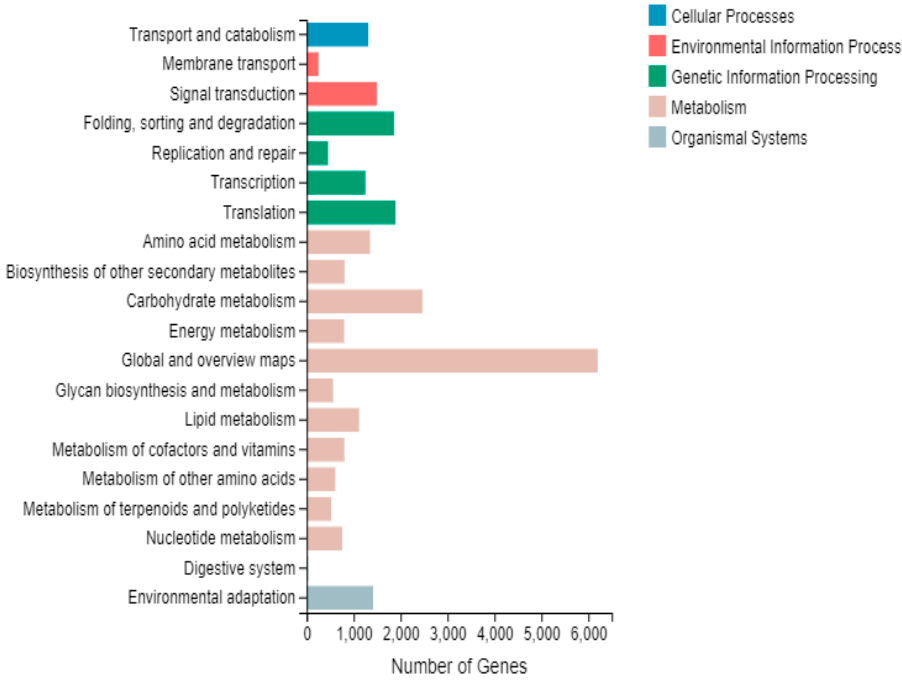
Figure 6. Category of KEGG annotation in differential gene.